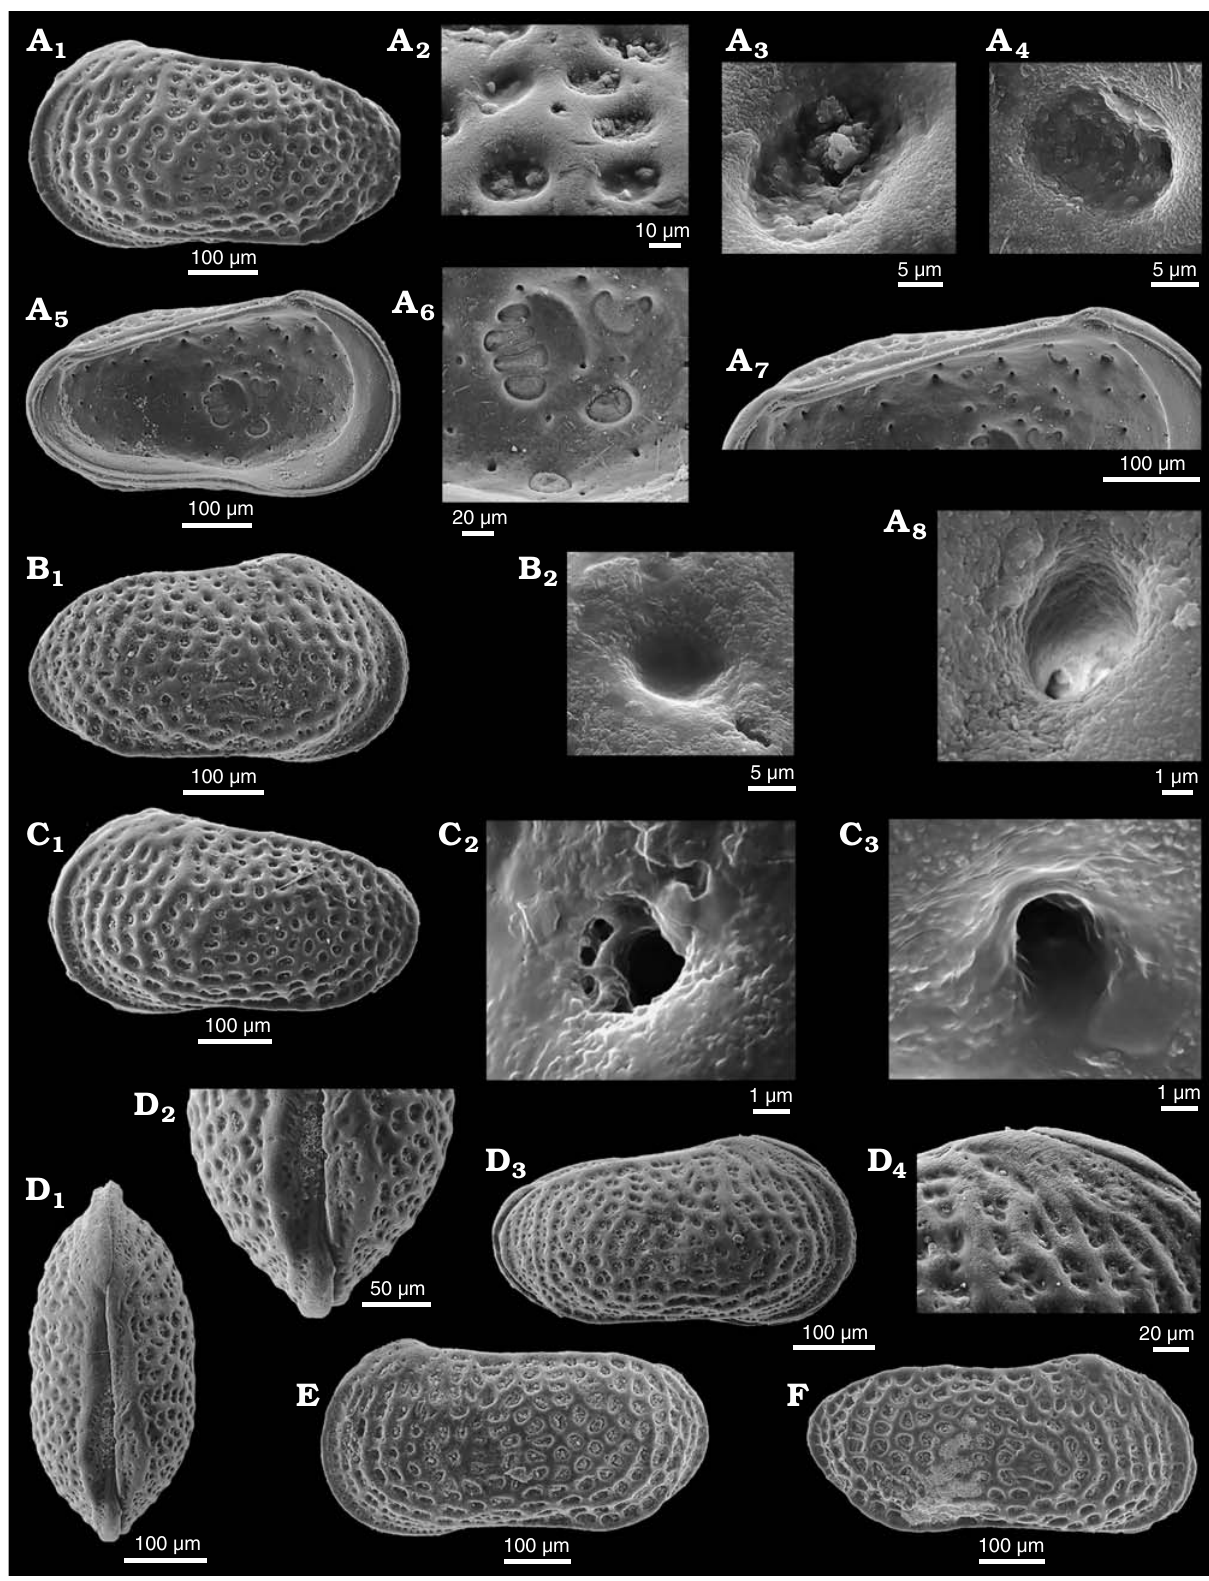
Fig. 18. Cytherid ostracod Dolocythere rara Mertens, 1956 from Borehole Lingen 196, 697–704 m (A, B), Borehole Rodewald WA6, 206 m (C), WA7, 383.7 m (E), Borehole ZW Losser 1, 256.4–258.4 m (F) from NW Germany, Lower Albian and Ziegelei Bekum (D) from NW Germany, Upper